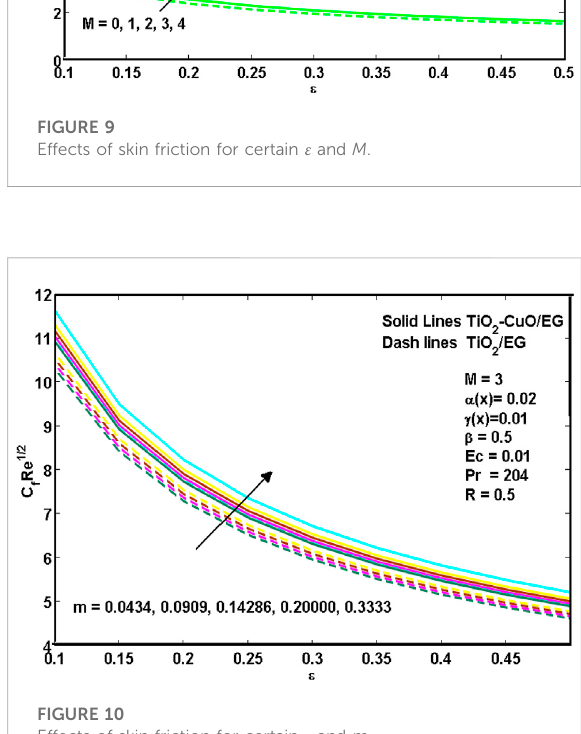
FIGURE 10 Effects of skin friction for certain ε and m